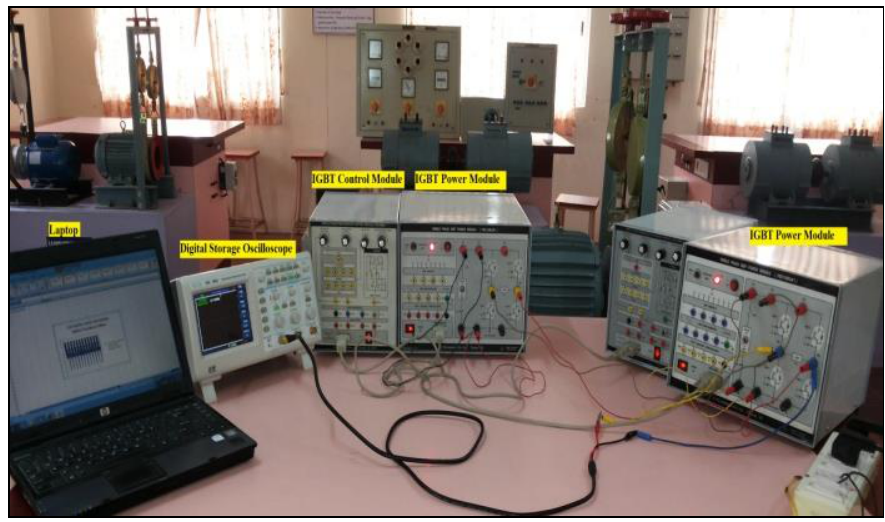
Figure 13. Laboratory experimental arrangement.